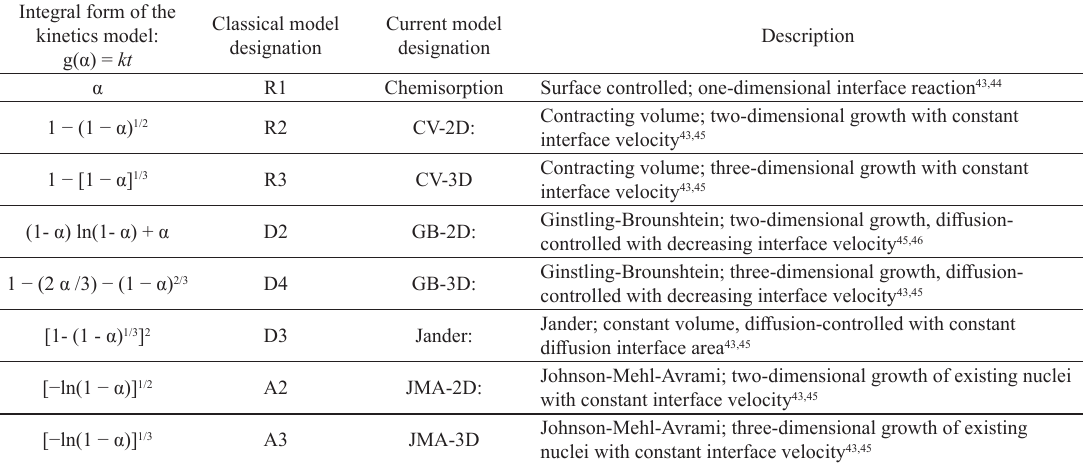
Table 1. Equations used for fitting the experimental sorption data (α is the reacted fraction as defined in the text) Integral form of the kinetics model: g(α) = kt